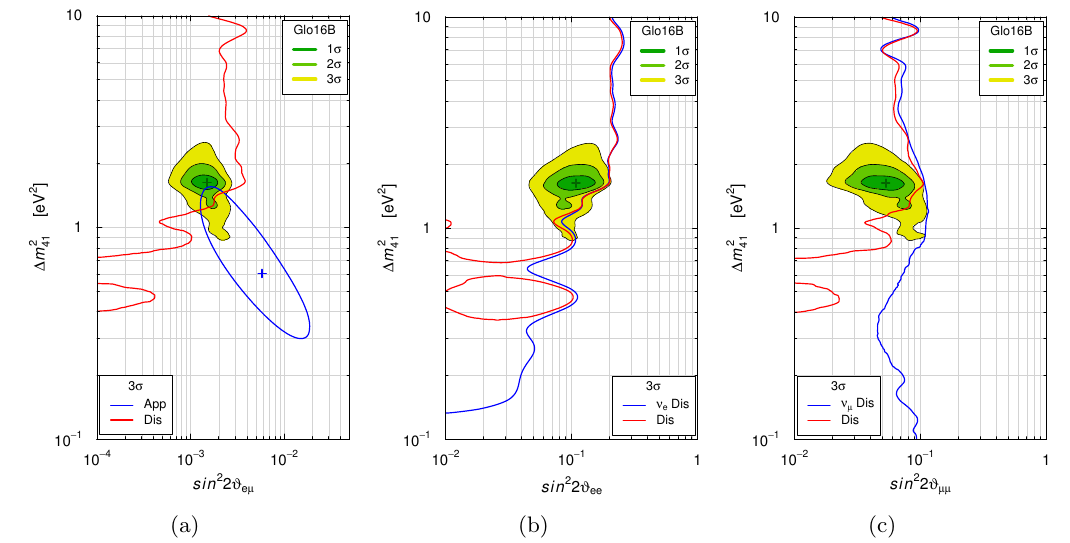
Figure 10 . Allowed regions in the sin 2 2 # e(cid:22) {(cid:1) m 2 (c), planes obtained in the 3+1 global (cid:12)t \Glo16B" of all 2016 SBL data. There is a comparison with the 3 (cid:27) allowed regions obtained from ( (cid:0) ) (cid:23) (cid:22) ! ( (cid:0) ) (cid:23) e SBL appearance data (App) and the 3 (cid:27) constraints obtained from ( (cid:0) ) (cid:23) e SBL disappearance data ( (cid:23) e Dis), ( (cid:0) ) (cid:23) (cid:22) SBL disappearance data ( (cid:23) (cid:22) Dis) and the combined ( (cid:0) ) (cid:23) e and ( (cid:0) ) (cid:23) (cid:22) SBL disappearance data (Dis). The best-(cid:12)t points of the Glo16B and App (cid:12)ts are indicated by